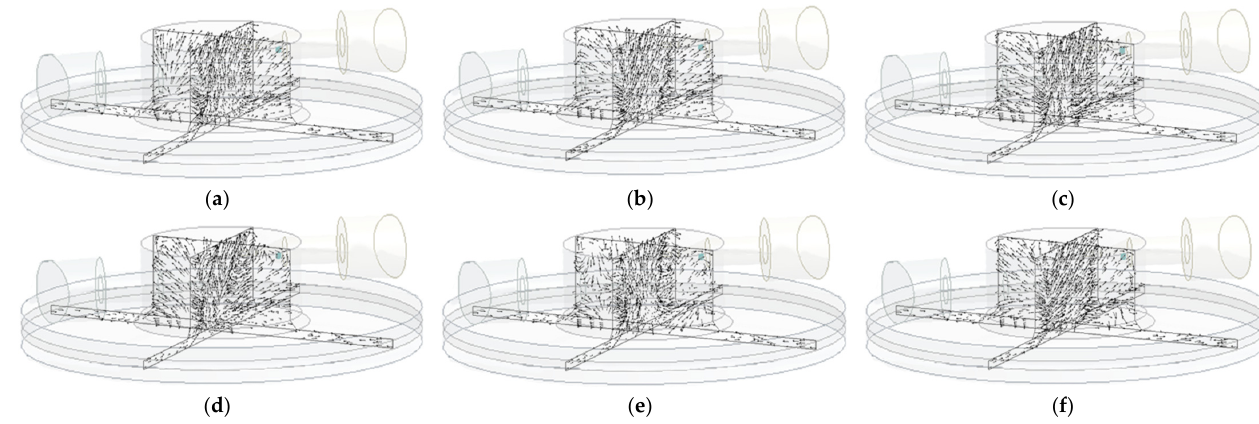
Figure 22. When inlet pressure = 15 MPa, gap = 1.5 mm, the variation of velocity vector of Suction cup- θ 20 with time in vertical axial cross planes at: ( a ) 5 ms, ( b ) 9.4 ms, ( c ) 13.8 ms, ( d ) 18.2 ms, ( e ) 22.6 ms, ( f ) 27 ms.